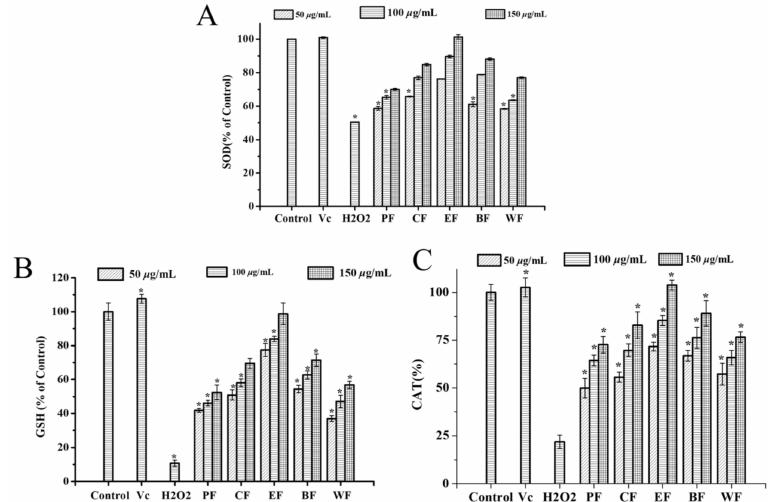
Figure 4. Effect of the PF, CF, EF, BF, and WF on antioxidant enzyme activity in H 2 O 2 -induced HepG-2 cells. ( A ) Superoxide dismutase (SOD) activity; ( B ) Catalase (CAT) activity; ( C ) Glutathione peroxidase (GSH-Px) activity; Means (bar values) with different letters are significantly different ( p < 0.05). PF, CF, EF, BF, and WF denoted petroleum ether fraction, chloroform fraction, ethyl acetate fraction, n -butanol fraction, and water